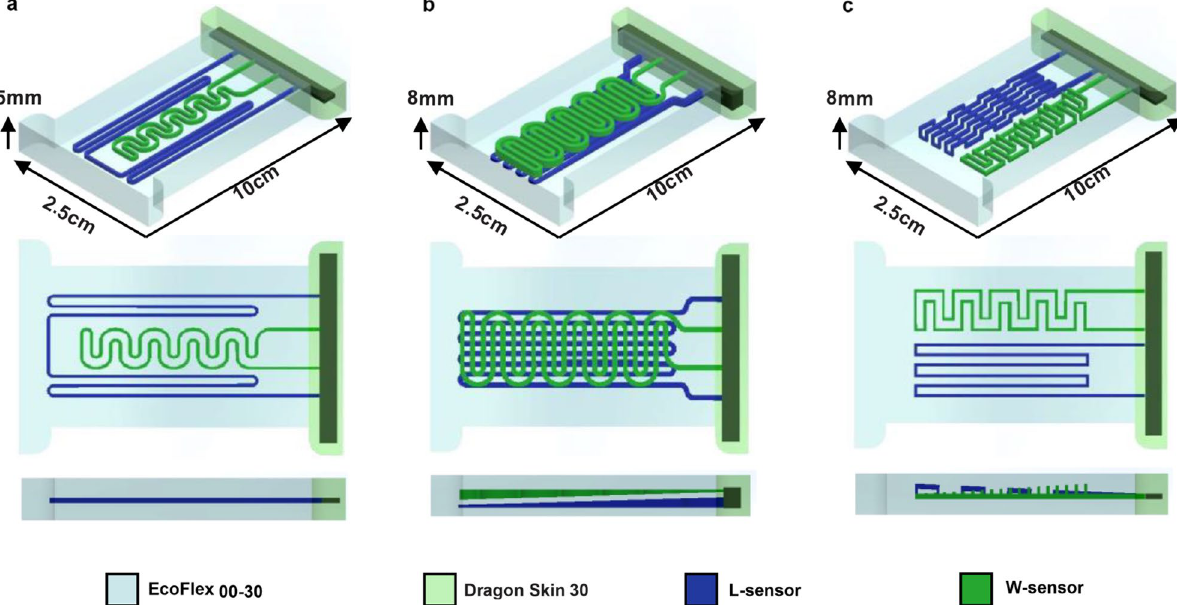
Figure 5. Three Sensor designs for different measuring purposes ( a ) Sensor Type-1 which is designed in planar structure ( b ) Sensor Type-2 which is designed in a double-decked structure ( c ) sensor Type-3 which is designed in fully 3D